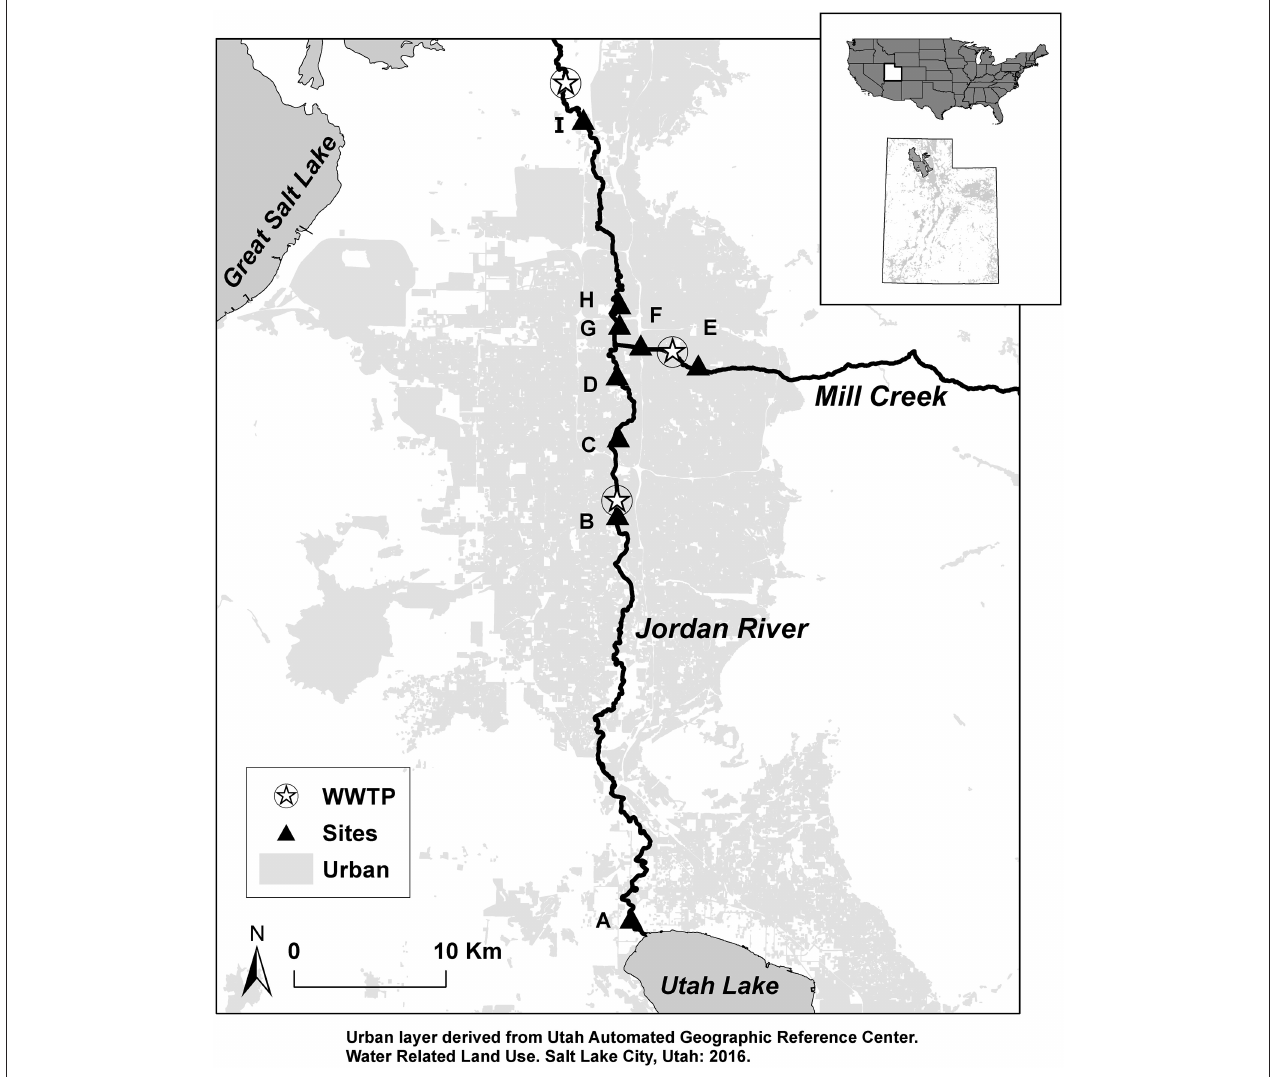
FIGURE 1 | Study sites (A–I) and wastewater treatment plants (WWTP) located along the Jordan River from Utah Lake to terminus the Great Salt Lake. Light gray represents urban land-cover.